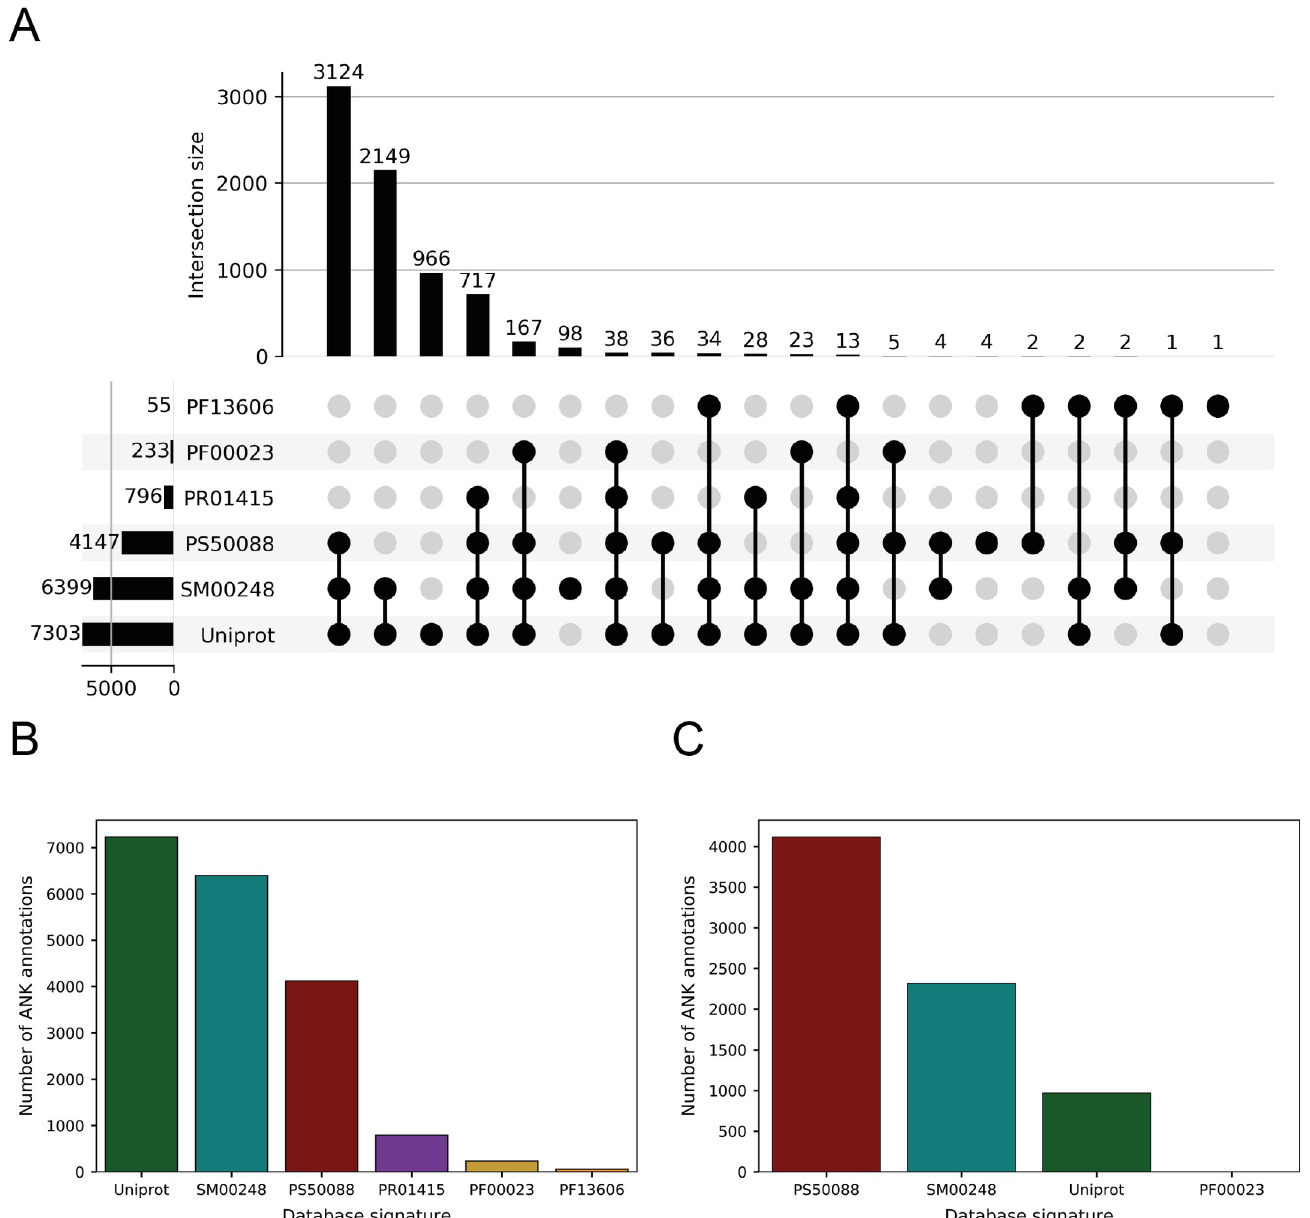
Fig 3. (A) Upset plot [27] showing the distribution of ANK annotations and the overlap between different database signatures. The vertical bar plot shows the total number of repeat annotations per database signature, whereas the horizontal one represents the number of annotations that are shared by the different signatures, i.e., the intersection between different sets of repeat annotations. For example, 3,124 out of the 7,303 repeats annotated by UniProt are shared with PS50088 and SM00248. Most of the annotations are shared between UniProt, SM00248 and PS50088. UniProt presents � 1000 unique annotations which are not present in any other database; (B) This bar plot indicates the number of ANK annotations per database signature: 7,230, 6,396, 4,119, 796, 233 and 55 from left to right; (C) This bar plot shows the composition of the dataset resulting from the database merging, with ProSite accounting for � 55% of the annotations, SMART for � 30% and UniProt for the last �